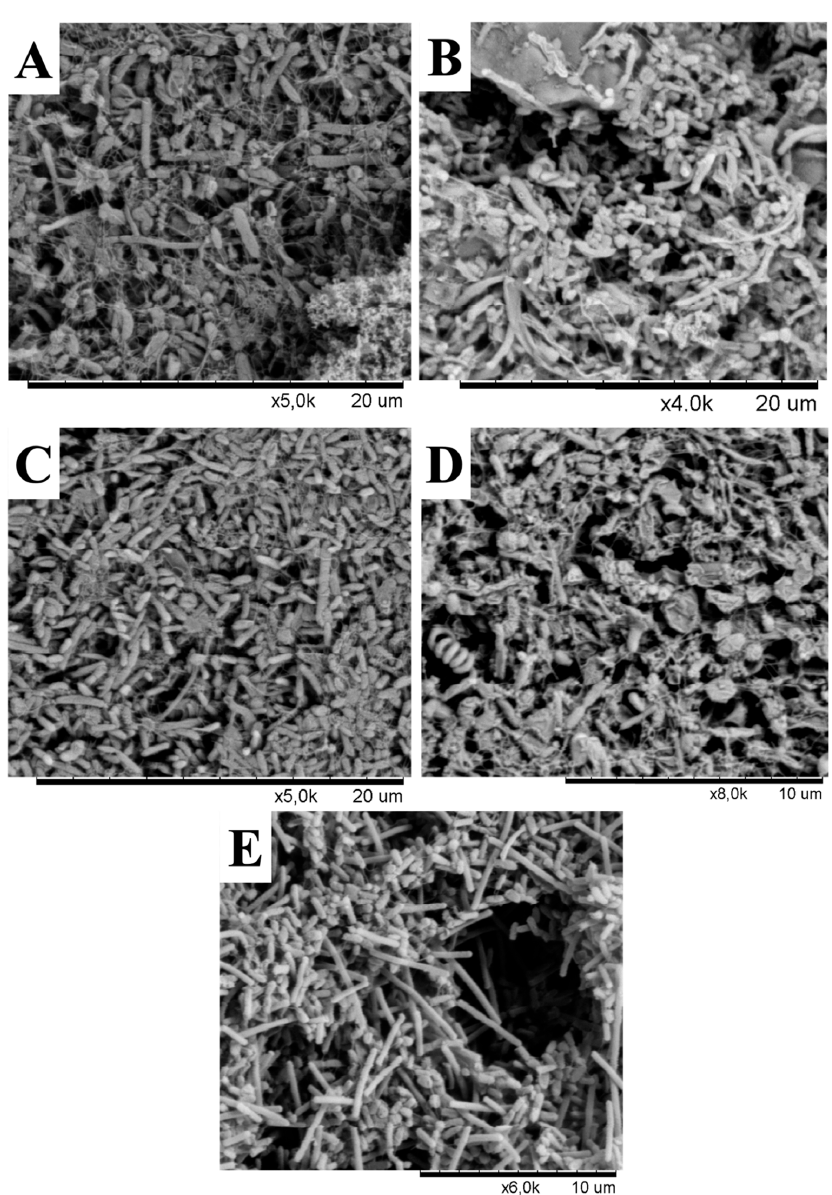
Figure 5. Scanning electron microscopy micrographs from enrichment cultures of hot springs. ( A ) P42, ( B ), P53A, ( C ), P53B, ( D ) P53C, and ( E ) P72.